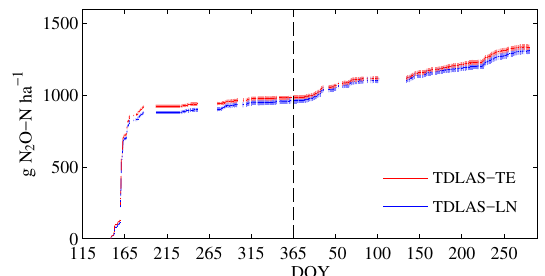
Figure 8. Cumulative (not gap-filled) N 2 O–N emissions. Shaded areas represent the p = 0.05 confidence intervals calculated using the random error